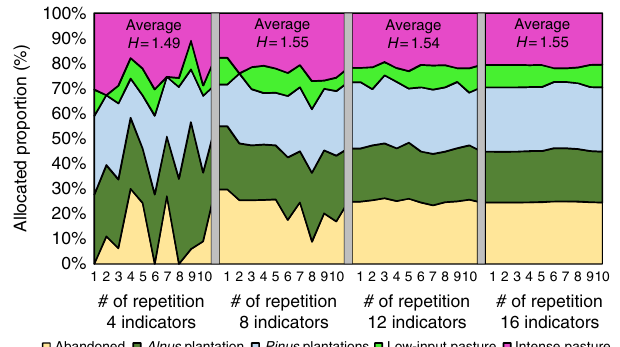
Figure 4 | Impact of the number of indicators considered (multifunction effect). Obtained composition of the landscape portfolios is relatively stable when using eight indicators or more. On the basis of four randomly selected indicators the average landscape composition is slightly less complex compared with that of landscapes that result from considering eight or more indicators. Random experiments with 10 repetitions with different indicator combinations for each size of the indicator set (4, 8, 12, and 16 indicators, all optimizations with uncertainty level f U ¼ 2.0) were carried out, with half of the indicators drawn from the ecological and half from the socioeconomic set. H stands for Shannon’s index computed for the average landscape composition.